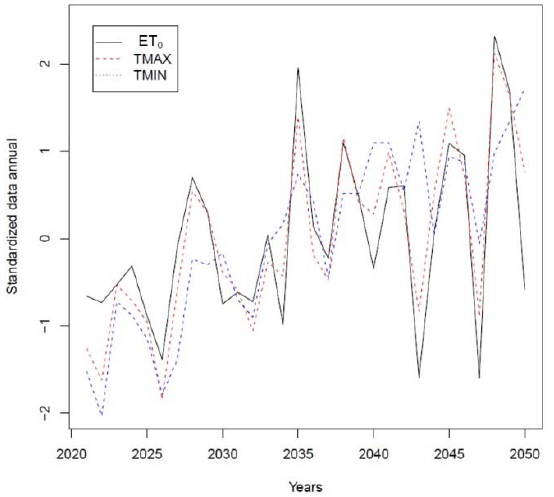
Figure 4. Standardized monthly data over continental Spain of RCM ensembles of ETo and maximum and minimum temperature for time period 2021–2050.